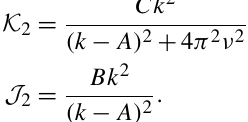
Figure 3. To determine the solution at any point, we consider runoff on only one hillslope (adjacent to link 1 in this case), and we trace the effects of that runoff downstream with no additional runoff from any subsequent